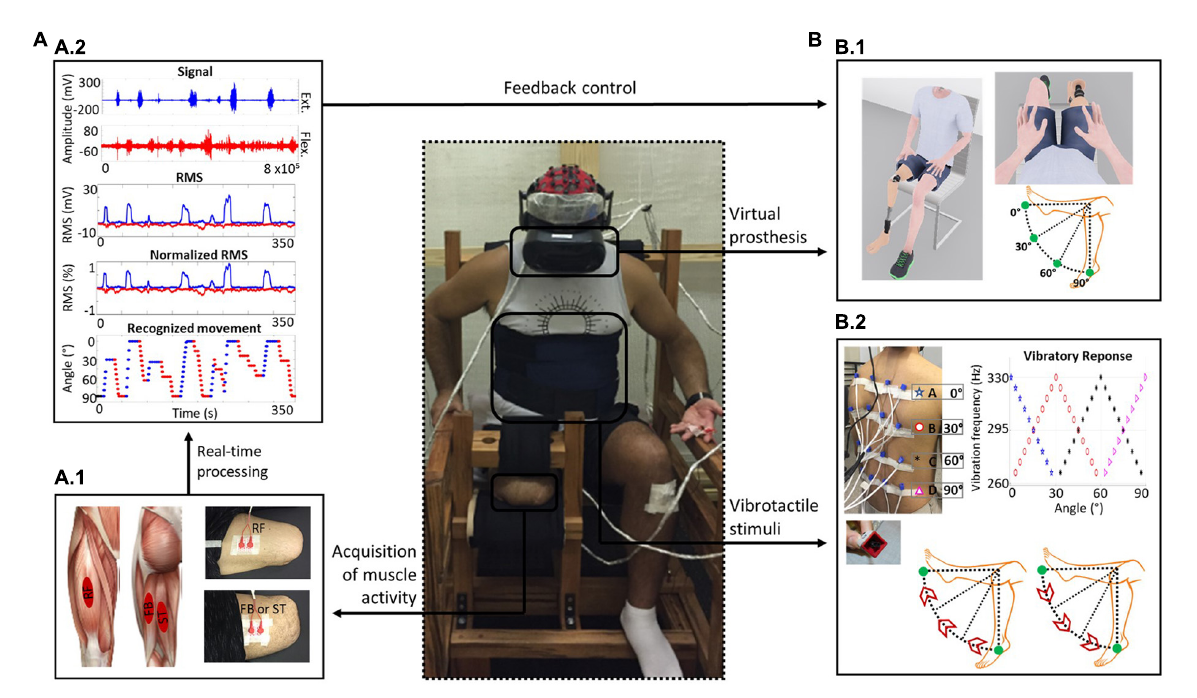
FIGURE1 EMG-based human-machine interface scheme. (A) Muscle activity recording through a surface EMG. (A.1) Illustration of the rectus femoris (RF) (hip flexor and knee extensor), femoral biceps long head (FB) and semitendinosus (ST) muscles (hip extensors and knee flexors) and positions of the surface electrodes on these muscles responsible for controlling the movements of the virtual prosthesis knee. (A.2) Schematic diagram of the real-time processing of electromyographic activity and root mean square (RMS) calculations to estimate the level of muscle contraction. The RMS was normalized to the maximum voluntary isometric contraction (MVIC) of each muscle. Regarding recognition of the movement direction, the activity of the agonist muscle should be twice as high as the average of the baseline signal, and the antagonist muscle could not exceed a threshold relative to the agonist, which was initially set at 80%. The recognized EMG patterns were mapped into visual and vibrotactile feedback. (B) Feedback. (B.1) Visual feedback. Avatar modeled with a transfemoral prosthesis and visualization from the first-person perspective are shown. The range of motion available to the prosthetic knee was set between 0 ◦ and 90 ◦ . (B.2) Vibrotactile feedback scheme. The positioning of vibrotactile actuators on the participant’s back was organized in a 4 × 4 matrix. The paradigm for the applied vibratory stimuli was associated with the movements of the virtual prosthesis: upward vibration during knee extension and downward vibration during knee flexion. The vibratory intensity peak of a given row corresponded to a specific angle of knee movement (row A, 0 ◦ ; B, 30 ◦ ; C, 60 ◦ ; and D, 90 ◦ ), with an overlap of 30 ◦ between adjacent